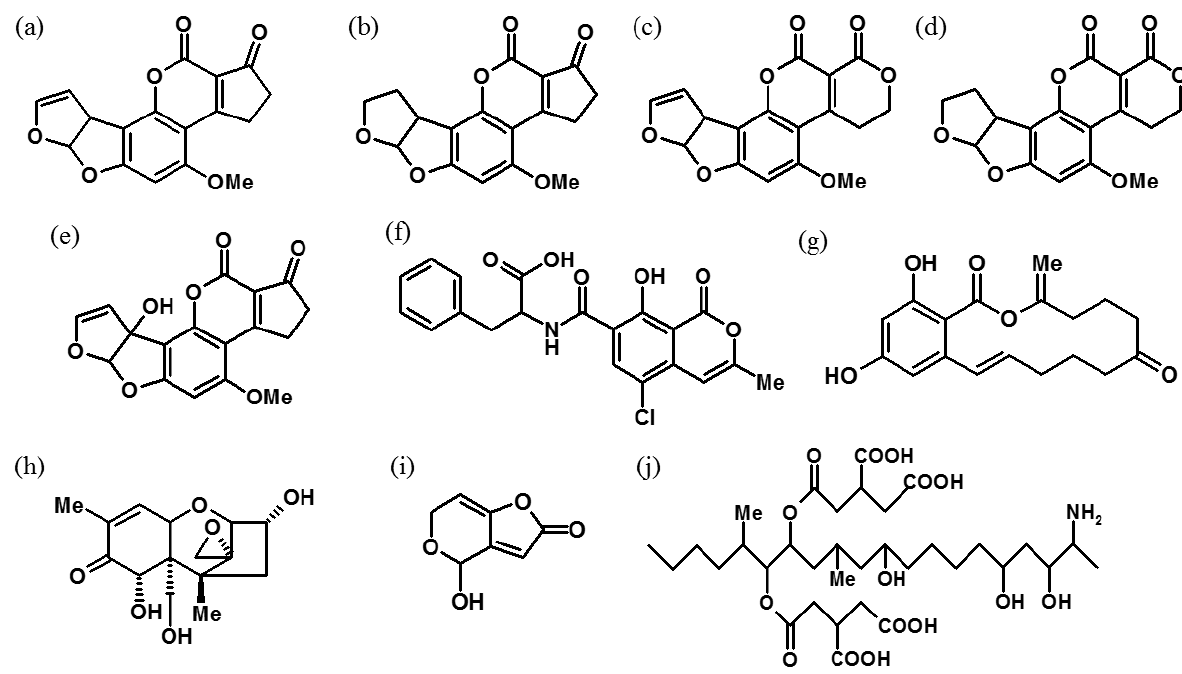
Figure 1. The chemical structures of ( a ) aflatoxin B 1 , ( b ) aflatoxin B 2 , ( c ) aflatoxin G 1 , ( d ) aflatoxin G 2 , ( e ) aflatoxin M 1 , ( f ) ochratoxin A, ( g ) zearalenone, ( h ) deoxynivalenol, ( i ) patulin and ( j ) fumonisin B 1 .